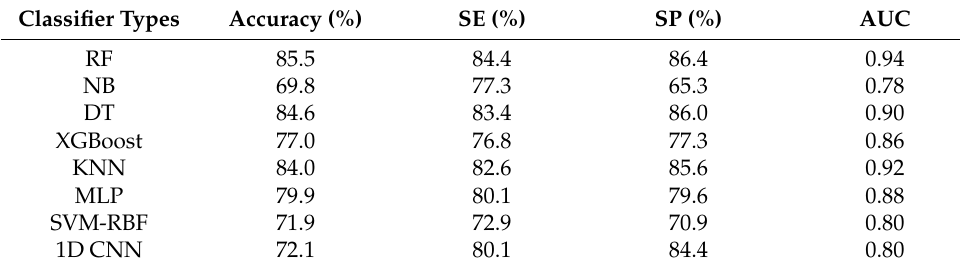
Table 5. Performances of ML-based classifiers for predicting children with ADHD.